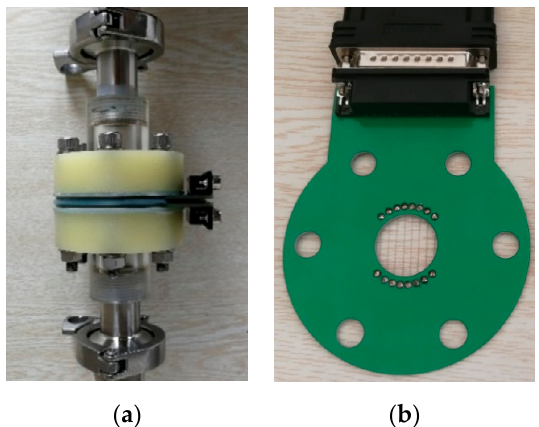
Figure 5. The conductance parallel-wire array probe used in the experiment: ( a ) CPAP; ( b ) Parallel electrodes.